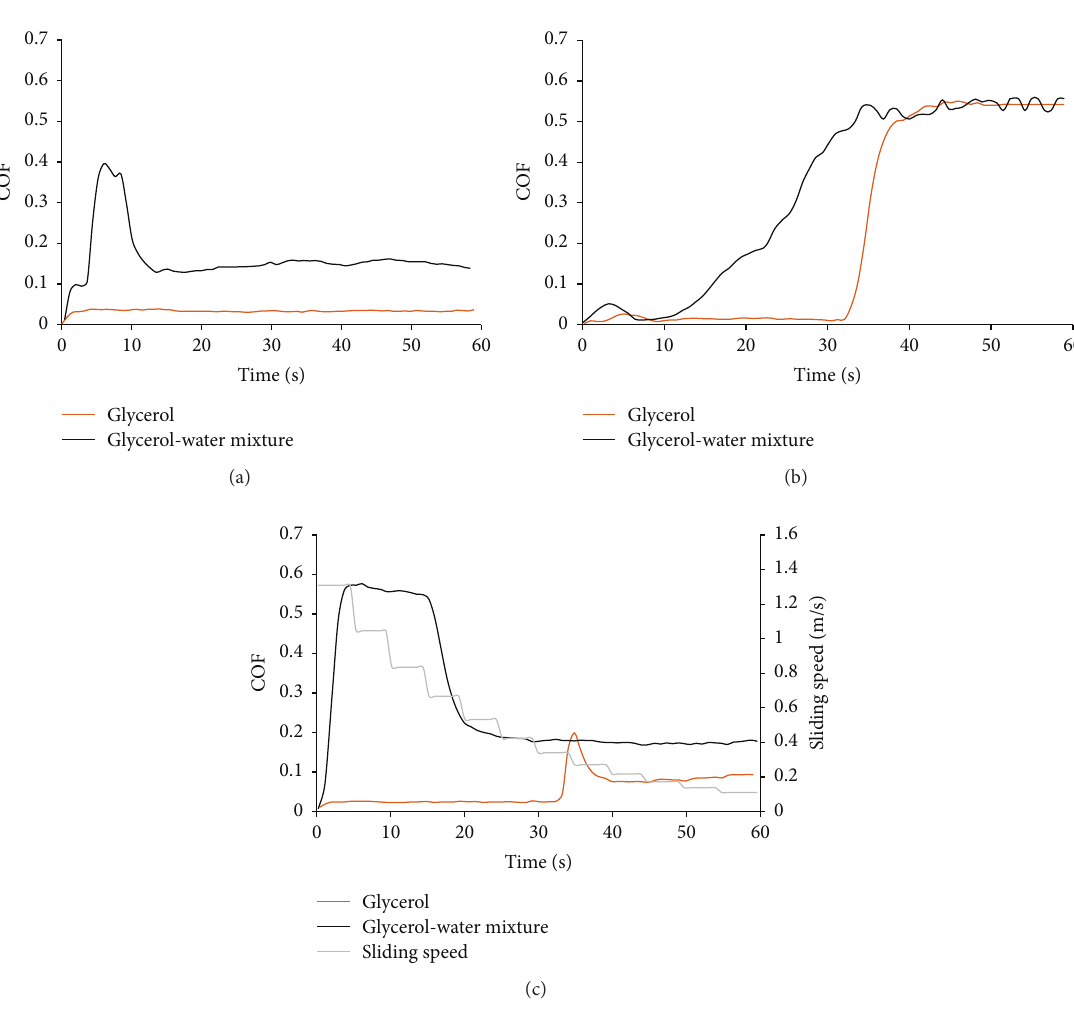
Figure 3: Friction coefficient of glycerol and glycerol-water mixture. (a) fixed point condition and circular geometry, (b) migrating point condition and spiral geometry, and (c) fixed point-variable speed condition and circular geometry.